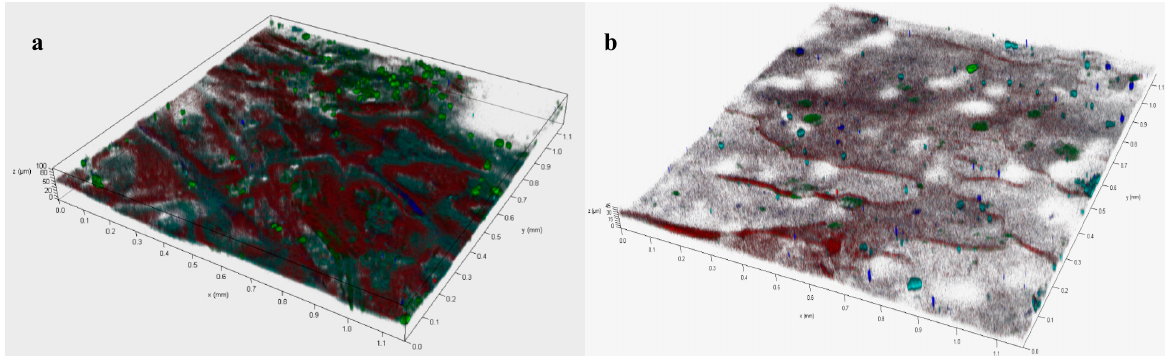
Figure 3. Surface images of the fouled microfiltration (MF) membranes: SEM images and EDX spectrums at different operating modes of constant flux ( a , c ) and varying flux ( b , d ).